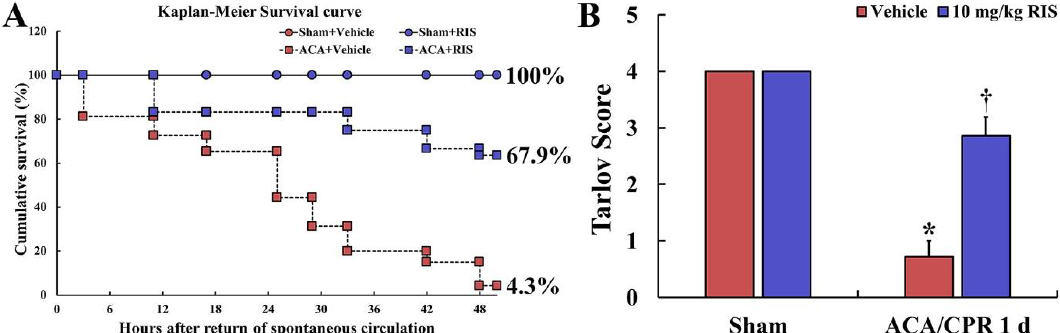
Figure 3. Kaplan-Meier survival curve and Tarlov score ( A ) Survival rate ( p < 0.05) in the Sham+vehicle, Sham+IRS, ACA/CPR+vehicle, and ACA/CPR+RIS groups using Kaplan–Meier analysis for 2 days after ACA/CPR. The ACA/CPR+RIS group reveals a higher survival rate than the ACA/CPR+vehicle group. At 2 days after ACA/CPR, the cumulative survival rate in the ACA/CPR+vehicle group is 4.3% whereas the cumulate survival rate in the ACA/CPR+RIP group is 67.9%. ( B ) Motor function of both hind limbs in the Sham+vehicle, Sham+RIS, ACA/CPR+vehicle, and ACA/CPR+RIS groups using Tarlov Scoring System. At 1 day after ACA, a significant higher score in the ACA/CPR+RIP group is observed compared to that in the ACA/CPR+vehicle group. The bars indicate the means ± SEM ( n = 7; * p < 0.05 vs. Sham+vehicle group; † p < 0.05 vs. ACA/CPR+vehicle group).